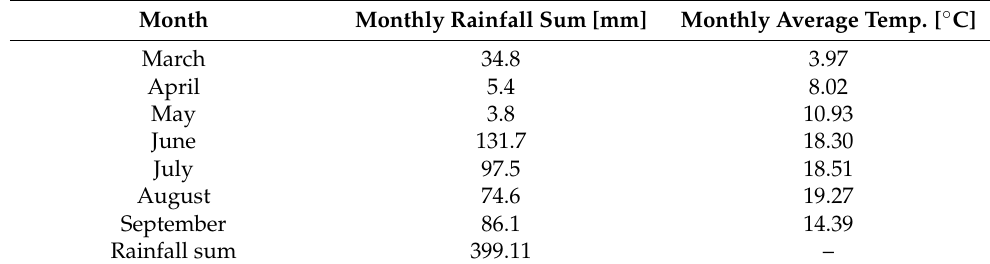
Table 2. Monthly rainfall sums and monthly average temperatures in the vegetation period of the study (April–September).